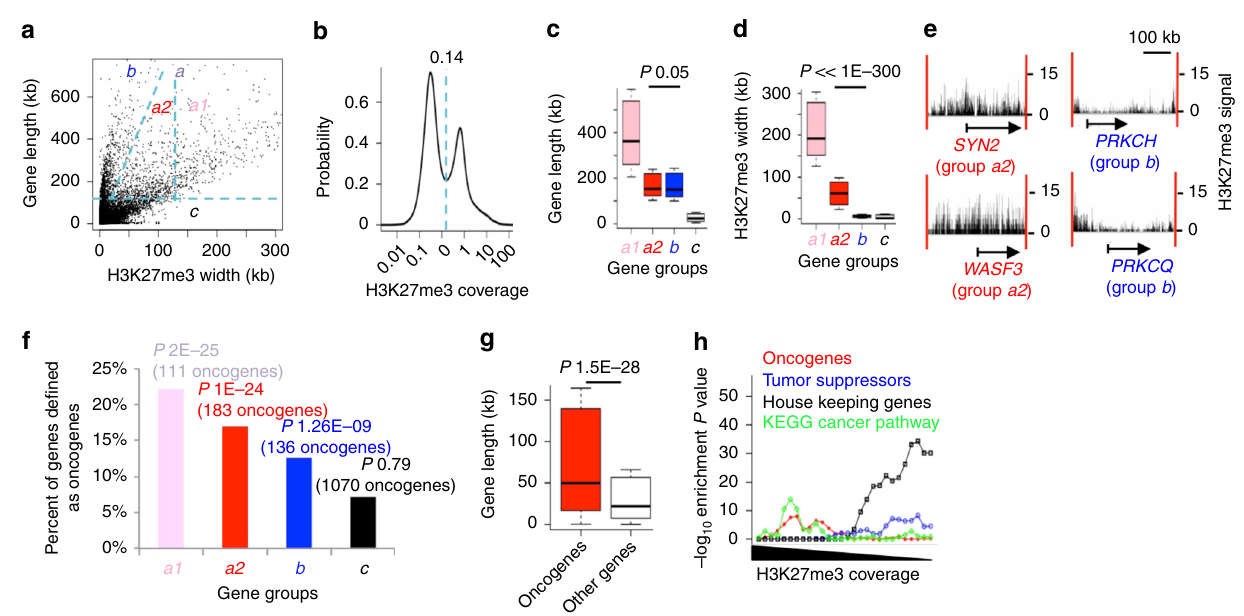
Fig. 2 BGRD genes tend to have a long gene body, whereas only a subset of long genes has BGRDs. a Gene length plotted against width of H3K27me3 ChIP-Seq enrichment peaks on the gene. Dash lines indicate the boundaries for individual gene groups, a1 (pink color), a2 (red color), b (blue color), and c (black color). b The probability distribution of H3K27me3 coverage values across all genes. The dash line indicates boundary between the two peaks in the distribution. Boxplot to show gene lengths ( c ) and repression domain widths ( d ) of each gene group indicated in a , n( a1 ) = 500, n( a2 ) = 1080, n( b ) = 1080, and n( c ) = 11880. e H3K27me3 ChIP-Seq signal at example genes. Arrows indicate gene loci. Gene names were indicated at the bottom. Y -axis scale at the right side indicates ChIP-Seq signal strength. The scale of region size was indicated on top. f Bar plot to show percent of oncogenes in individual gene groups. The number of oncogenes and P value of oncogene enrichment were indicated on top of each bar. g Boxplot to show length of oncogenes and other genes, n = 500 for each group. h Enrichment level of each gene category plotted against H3K27me3 coverage of each gene. Coverage de fi ned as the width of H3K27me3 ChIP-Seq enrichment peaks divided by gene length. Genes were ranked by H3K27me3 coverage and divided into groups that each contains 1500 genes, with two neighboring groups in the rank has 500 genes in common. A dot in each curve indicates the enrichment level ( Y -axis) of one of these groups ( X -axis) in the oncogenes, KEGG cancer pathway genes, tumor suppressor genes, or housekeeping genes as indicated by the color legends. P values calculated by one tail Wilcoxon test c , d , g or one tail Fisher ’ s exact test f , h . Box plots: center line is median, boxes show fi rst and third quartiles, whiskers extend to the most extreme data points that are no more than 1.5-fold of the interquartile range from the box. Source data are provided as a Source Data fi